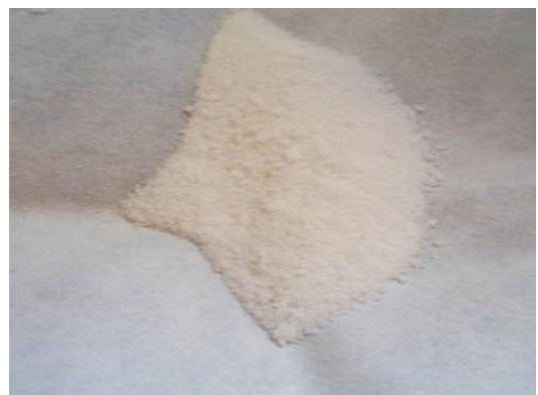
Figure 5. Microencapsulated paraffin in powder form.